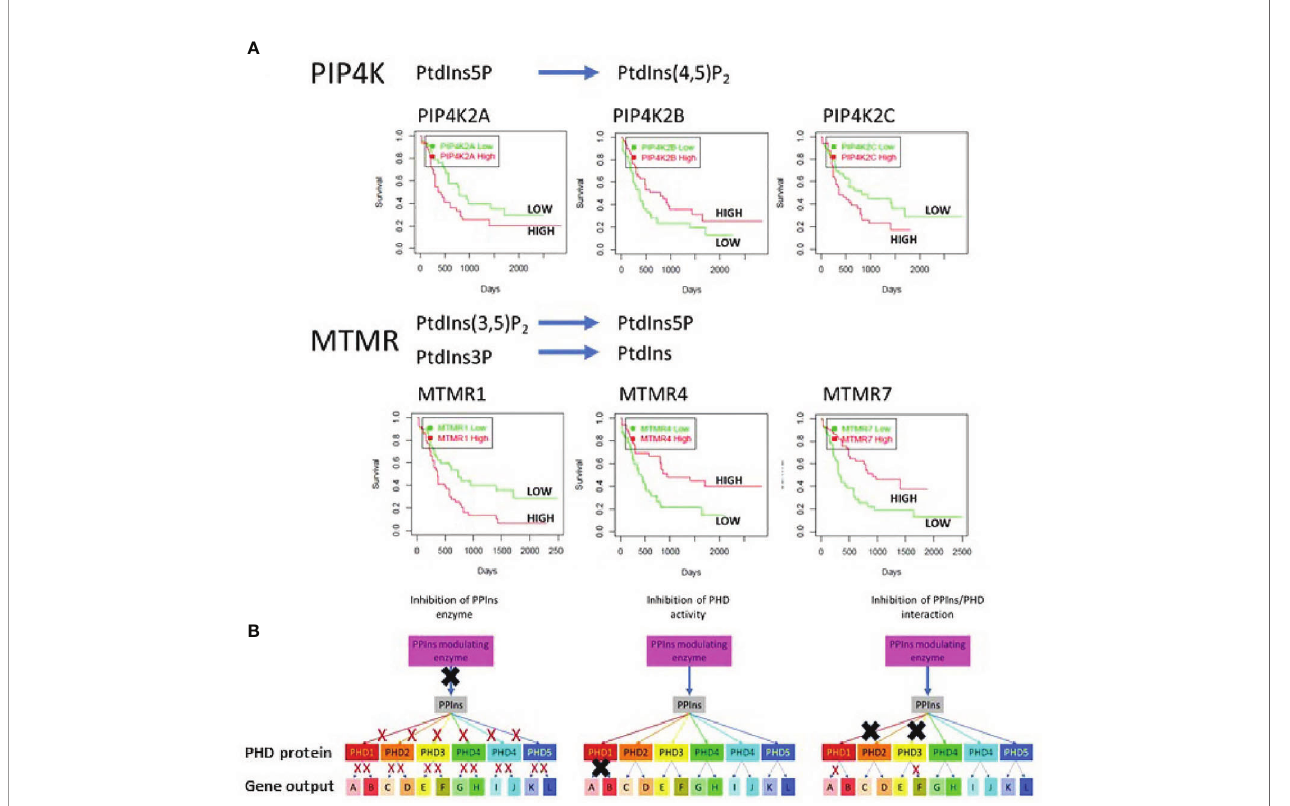
FIGURE 4 | (A) The TGCA AML patient data base was used to assess survival outcomes with respect to low or high expression of various PPIns modulating enzymes to demonstrate complex signalling and outcomes within enzymes from the same family. As examples we shown that low expression of PIP4K2A, PIP4K2C or MTMR1 is associated with increased survival. Surprisingly however the expression of PIP4K2B, a family member with PIP4K2A and 2C shows survival outcomes that are opposite with respect to its expression. Similar data are observed MTMR4 and 7 where high expression is associated with increased survival in AML. These data suggest that the complexity in PPIns signalling could be exploited to generate modulatory pathways that could be bene fi cial for AML treatment. (B) A schematic diagram illustrating that PPIns inhibitors could act at 3 points within a PPIns signalling unit: (i) inhibition of the PPIns modulating enzyme will impair all downstream targets and associated gene expression programs (A:L) (ii) inhibition of the activity of a PHD containing protein will likely impair all the genes that the protein regulates (gene A and gene B) or (iii) allosteric inhibition of in the interaction of PPIns with a speci fi c interacting domain will impair selected output which might be tuned to speci fi c pathways and therefore engender less toxic outcomes. In this example inhibition of two PHD domain interactions is shown which impair expression of gene A and gene